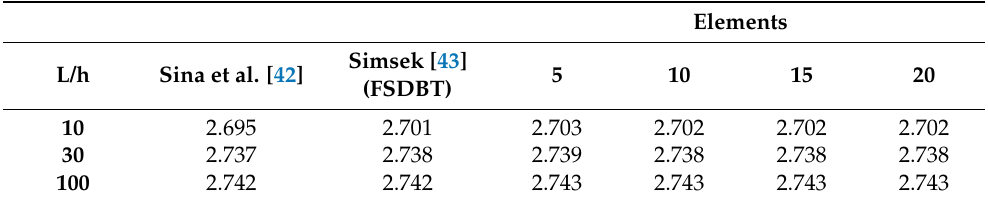
Table 1. Nondimensional fundamental frequency Ω adim of metal–ceramic FGM beam. Conver- gence test.